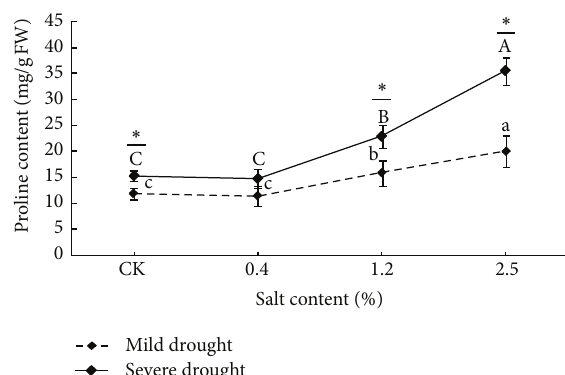
Figure 3: The changes of proline contents under different salt and drought stresses. The different letters within the same treatment indicate the significant difference at 0.05 level. The “ ∗ ” stands forthe significant difference at 0.01 level between two treatments under the same salt